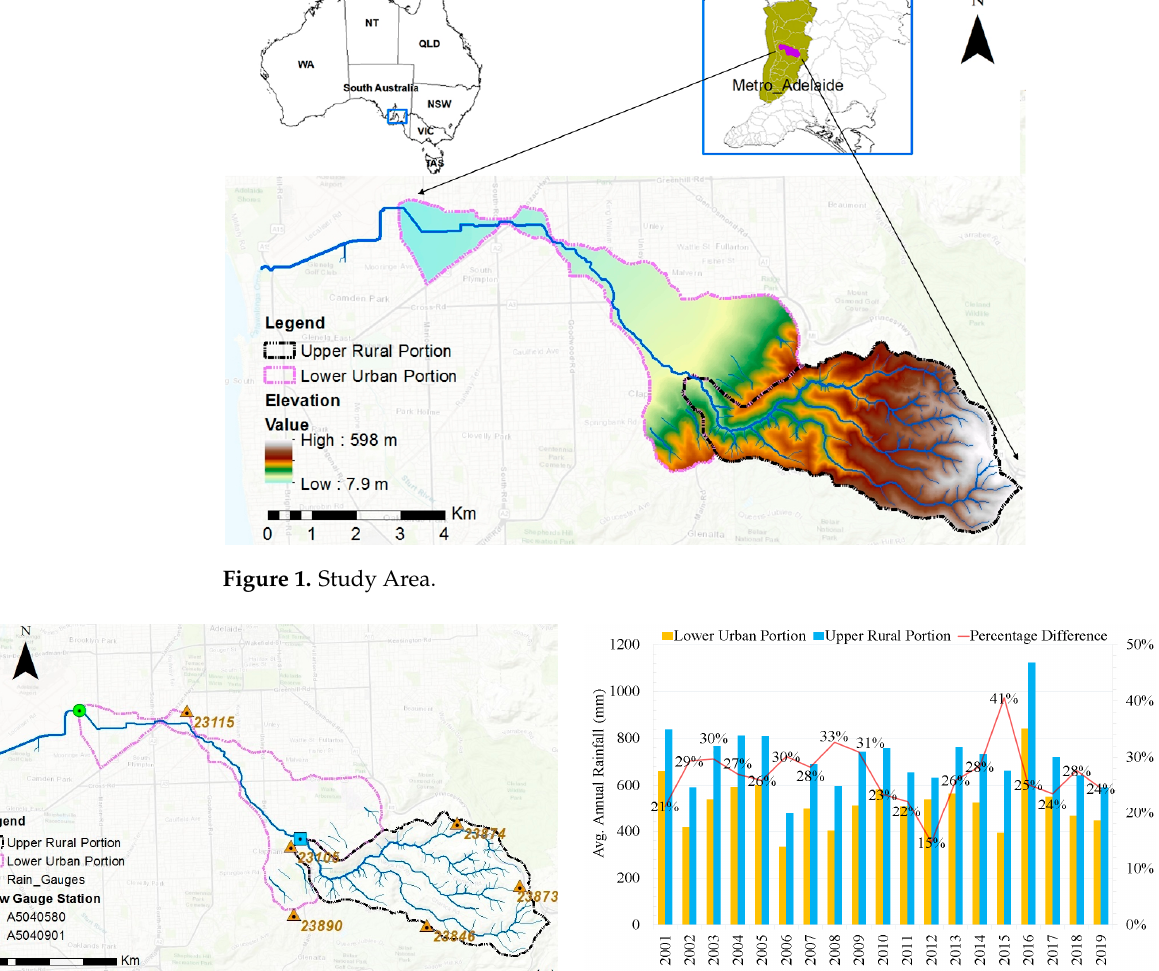
Figure 2. BHC catchment ( a ) Gauging stations and ( b ) Average annual rainfall comparison